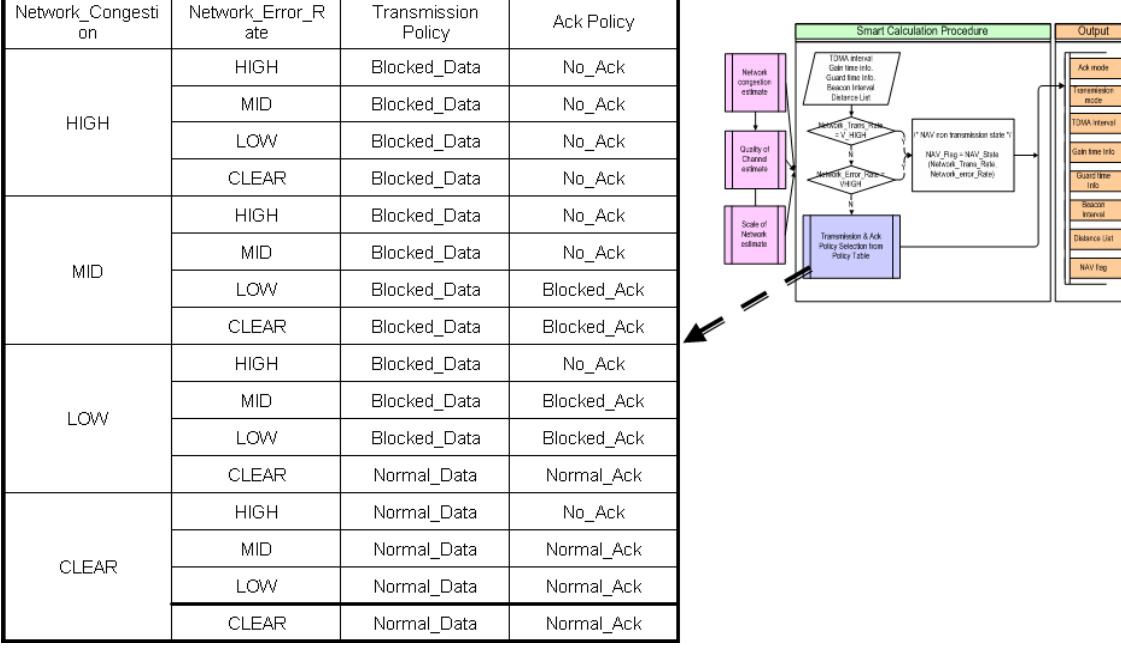
Figure 9. An example of Policy